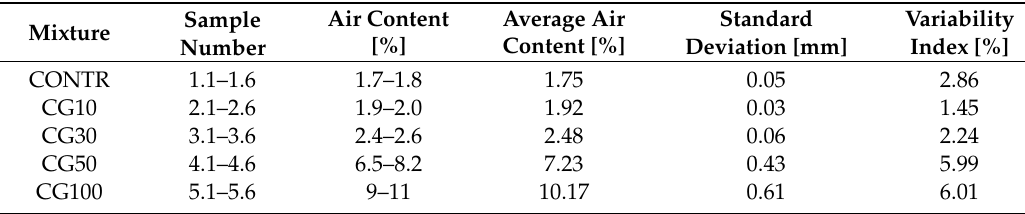
Table 8. Results of testing the air content of concrete mixes.